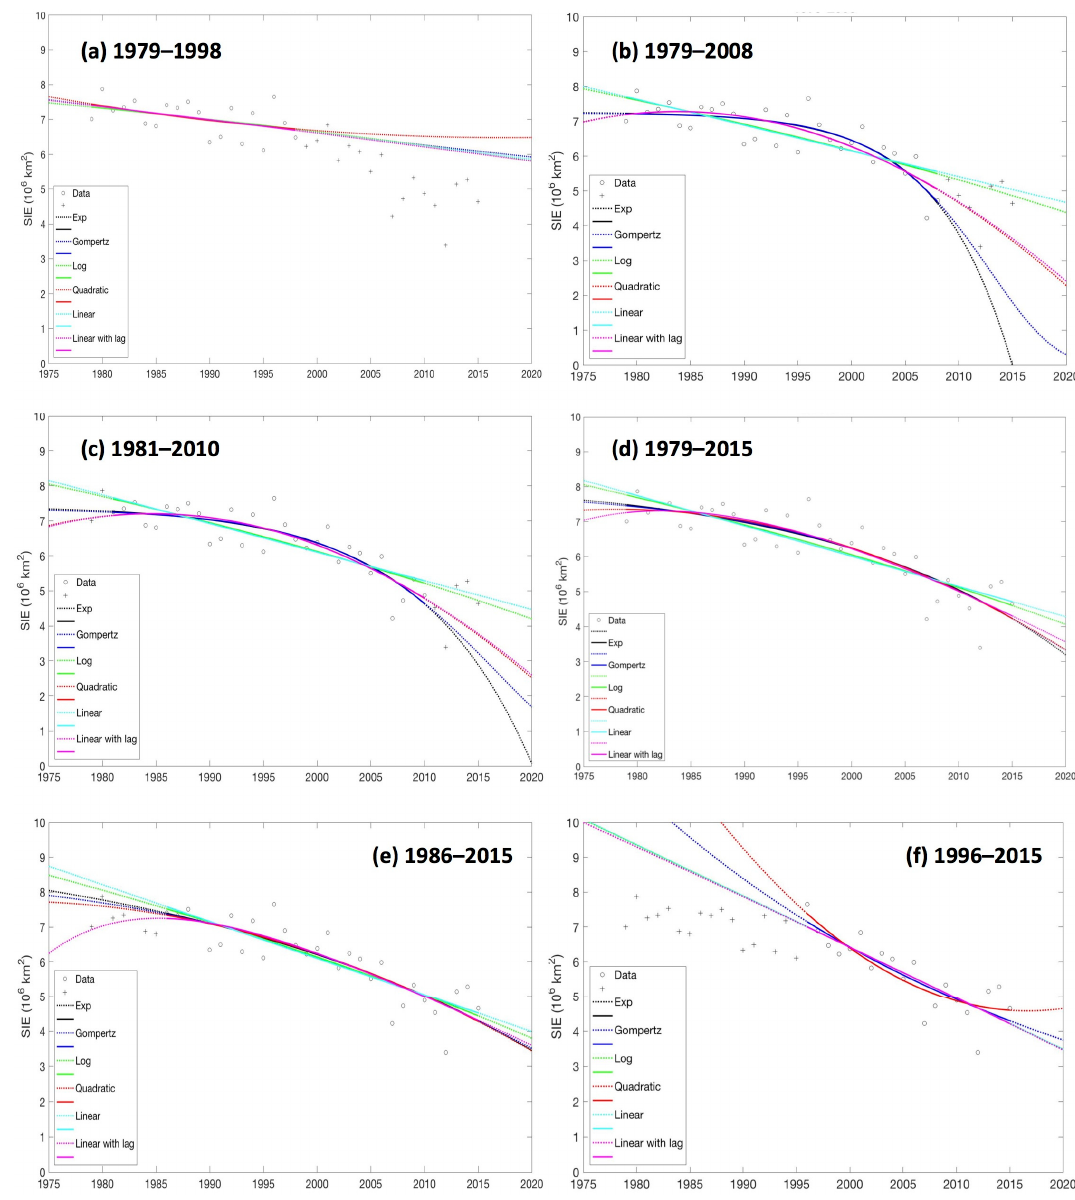
Figure 4. Model predictions of annual SIE minimums using different sub-periods of the dataset for training. Circles denote data values used for model training and the predictions over the training set are denoted by solid lines. Plus-signs denote data points excluded from the fitting and dotted lines are the extrapolated predictions based on the resultant fitting.